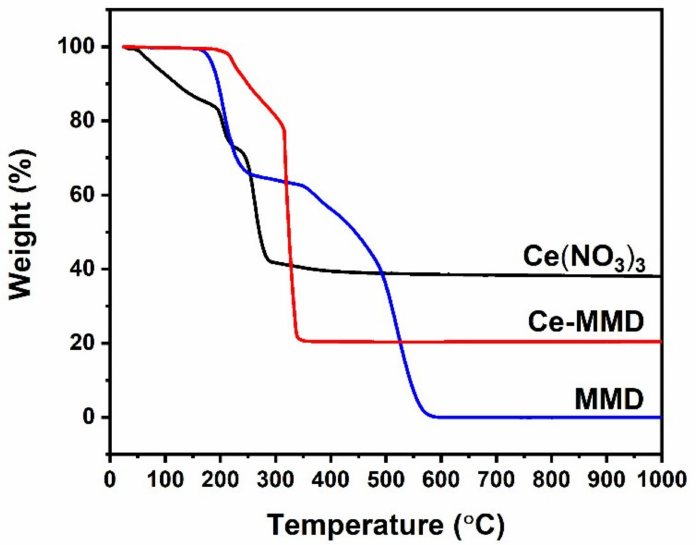
Figure 11. TGA thermograms of cerium(III) nitrate hexahydrate, the MMD ligand, and the Ce-MMD